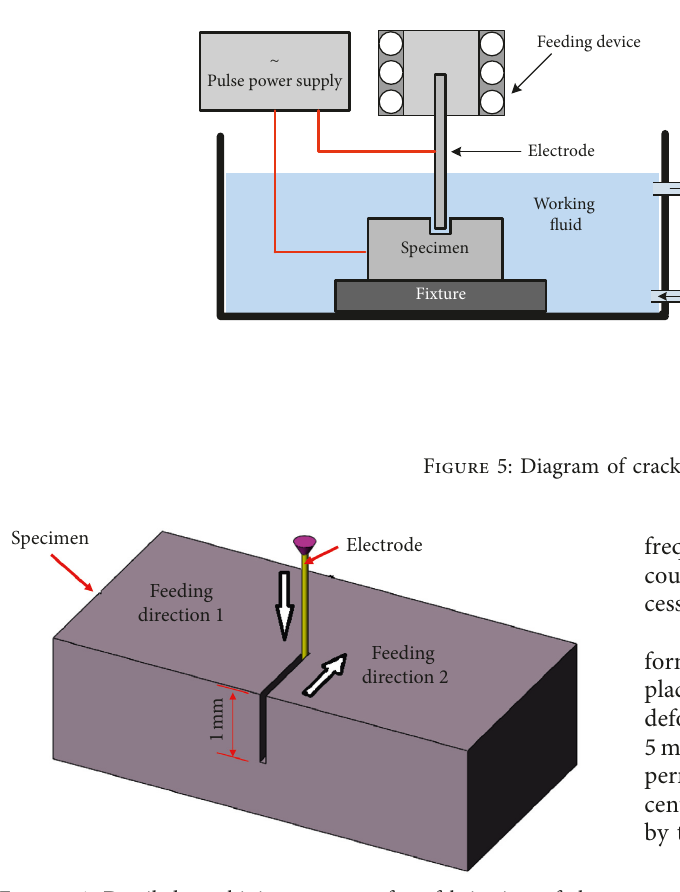
Figure 6: Detailed machining process of prefabrication of the